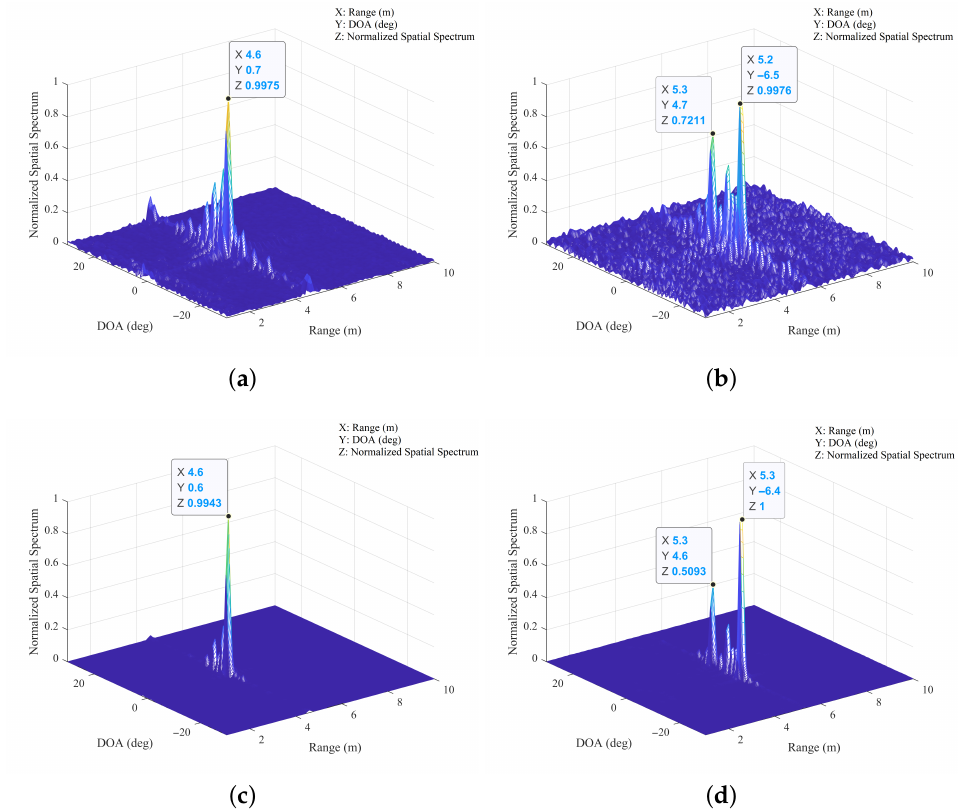
Figure 11. Imaging: ( a ) Single target with Nystrom-based 2D-MUSIC. ( b ) Two targets with Nystrom-based 2D-MUSIC. ( c ) Single target with 2D-MUSIC. ( d ) Two targets with